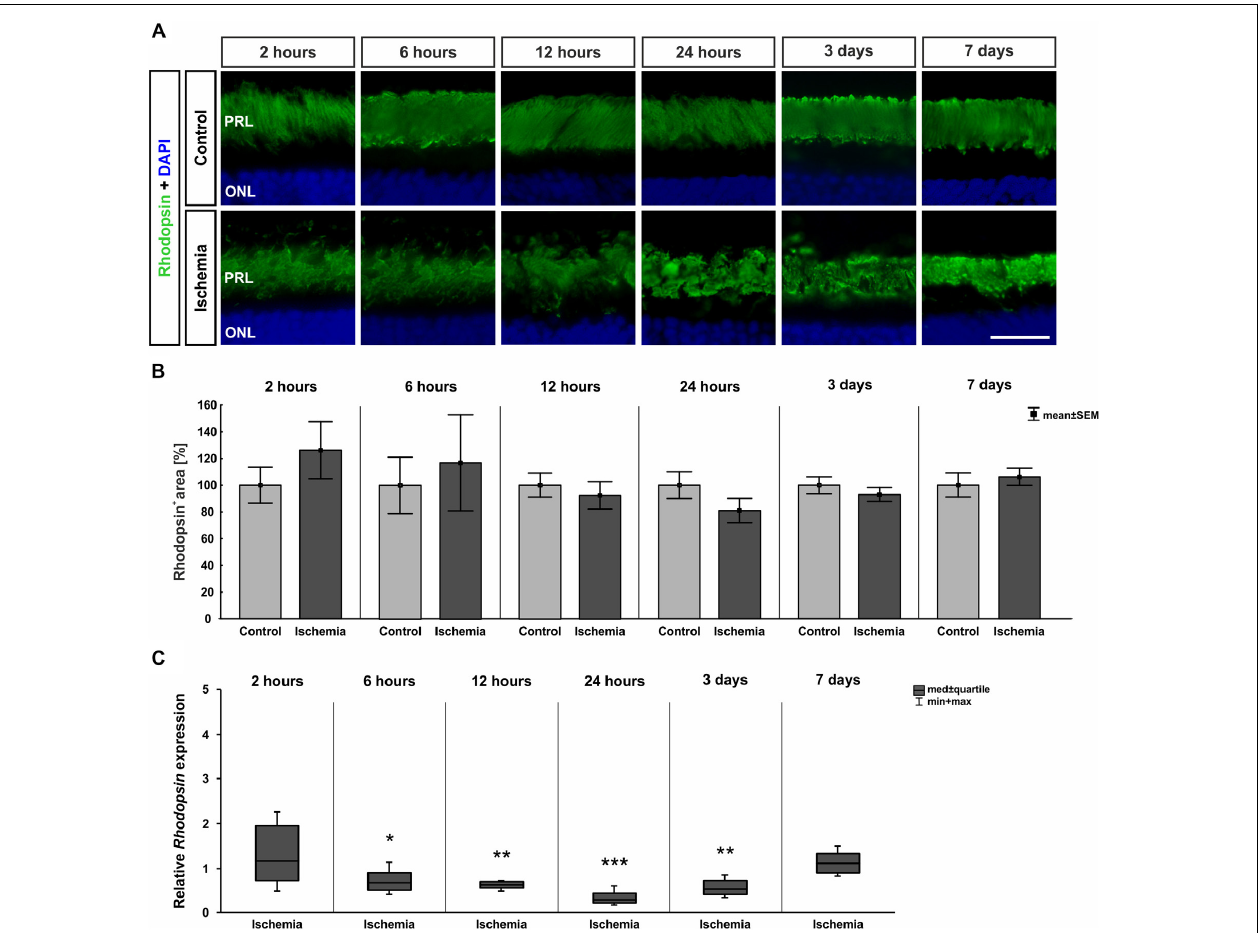
FIGURE 8 | (A) Rod photoreceptor cells were stained with anti-rhodopsin (green; n = 7–8/group). DAPI marked cell nuclei (blue). While in control retinae the structure was well defined, a disorganization was noted after ischemia at later points in time. (B) Regarding the analyses of rhodopsin + staining area, no differences were seen at all points in time. (C) Certainly, on mRNA level, a significant down-regulation of Rhodopsin mRNA expression could be shown in the ischemia group after 6 h ( p = 0.026), 12 h ( p = 0.007), 24 h ( p < 0.001), and 3 days ( p = 0.008). ∗ p < 0.05, ∗∗ p < 0.01, ∗∗∗ p < 0.001. PRL, photoreceptor layer; ONL, outer nuclear layer. Scale bar: 20 µ